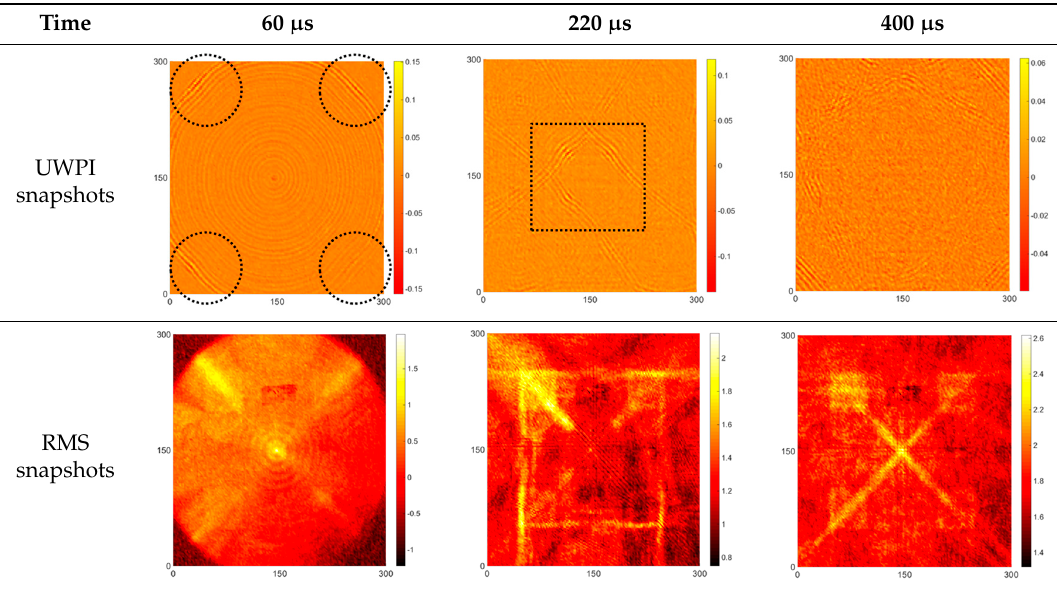
Table 3. UWPI and RMS snapshots of the back side of Specimen 1 at 60 μ s, 220 μ s and 400 μ s (the unit of x and y axis: mm).